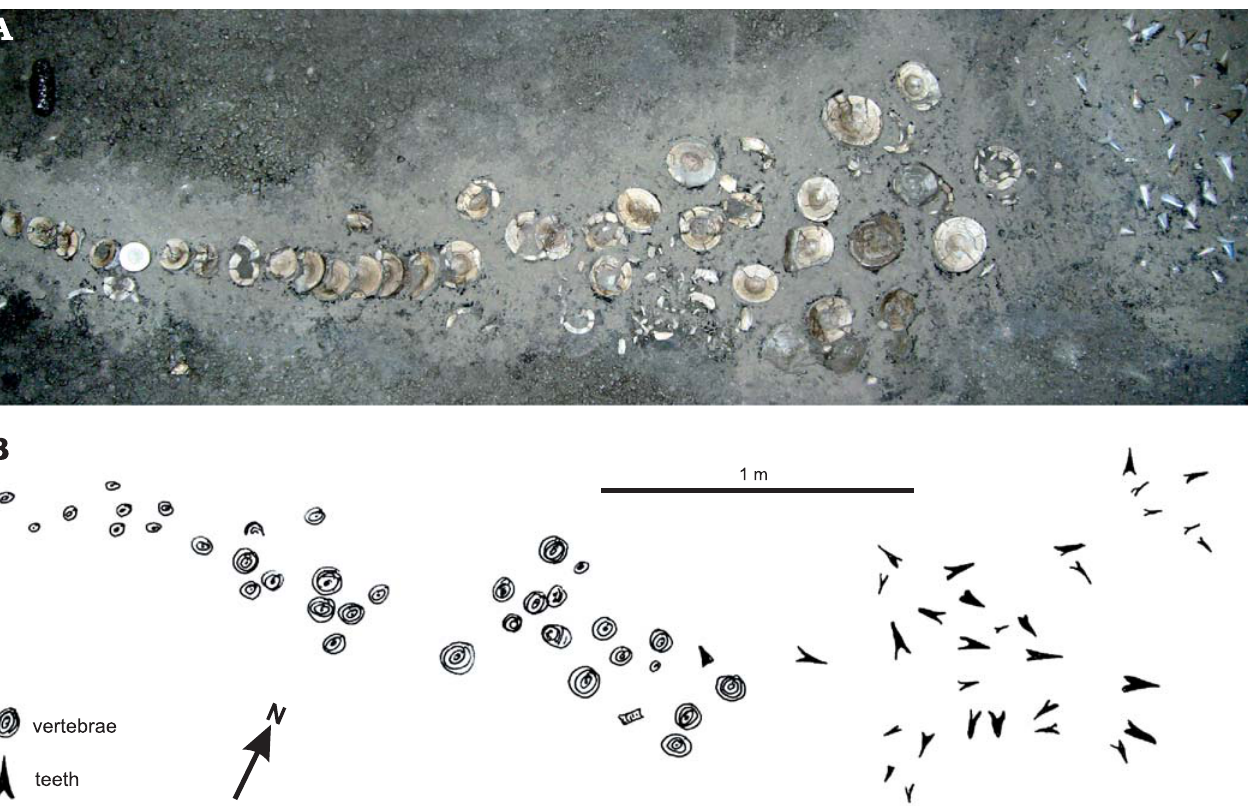
Fig. 2. Photograph ( A ) of mounted specimen MNU 071-20 of the mackerel shark Carcharomodus escheri (Agassiz,1843) in the museum and drawing ( B ) of its in situ finding position, in Groß Pampau, the middle–late Miocene, depicting preserved teeth and vertebral centra. The large anterior vertebrae were recovered from the sediment after the in situ drawing during the excavation was